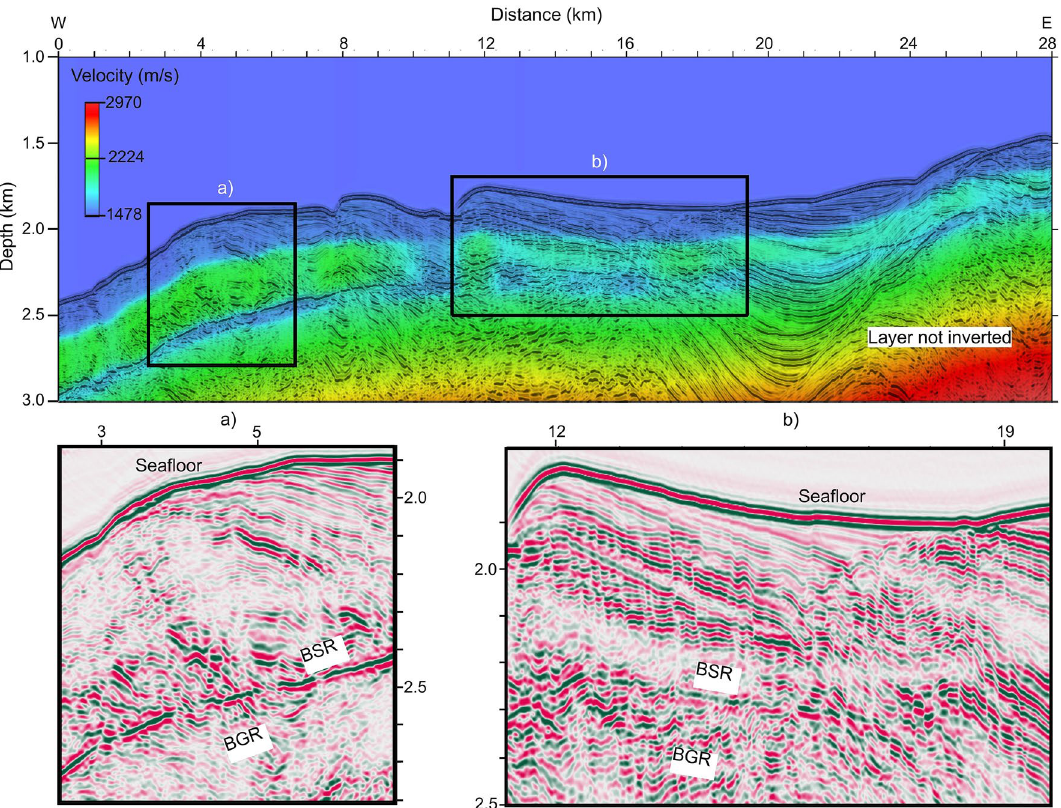
Figure 5. Velocity model superimposed to the KPSDM section. The rectangles in the section indicate the position of the zooms ( a , b ), in which BSR and BGR were identified. The figure in ( a ) was generated using Free & Open Source Image Editor GNU Image Manipulation Program GIMP (v. 2.10.24; https:// www. gimp. org) and edited-labeled with the Open Source Desktop Publishing Scribus (v. 1.5.6.1; https:// www. scrib us.